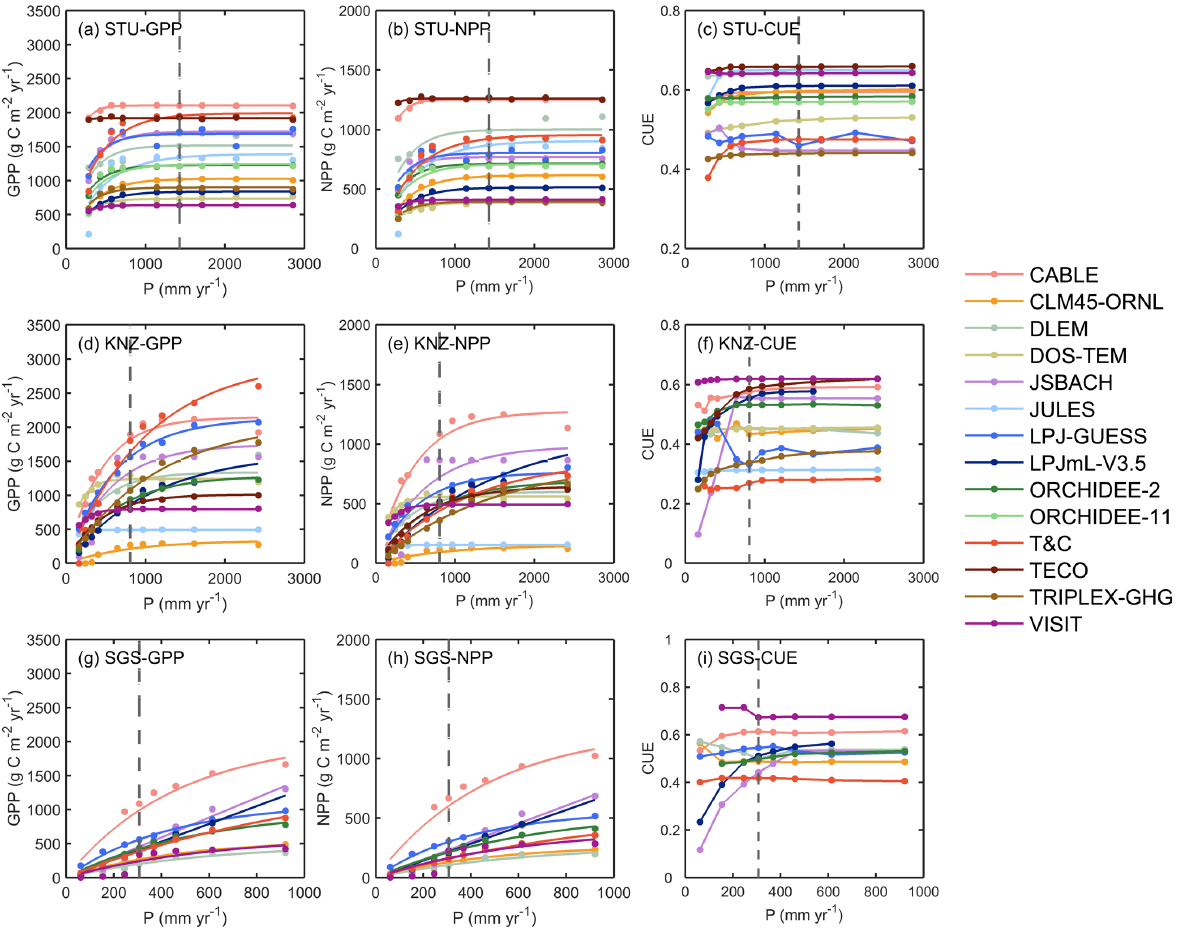
Figure 4. Responses of simulated annual GPP (a, d, g) , NPP (b, e, h) and CUE (NPP/GPP; c, f, i ) to altered and ambient precipitation ( P ) levels at the three sites STU, KNZ and SGS. The fitted equation is Eq. (8) for GPP and NPP (see Fig. S3 for fitted a and b ). The grey dashed line represents ambient precipitation. It should be noted that the x -axis scales are different between the